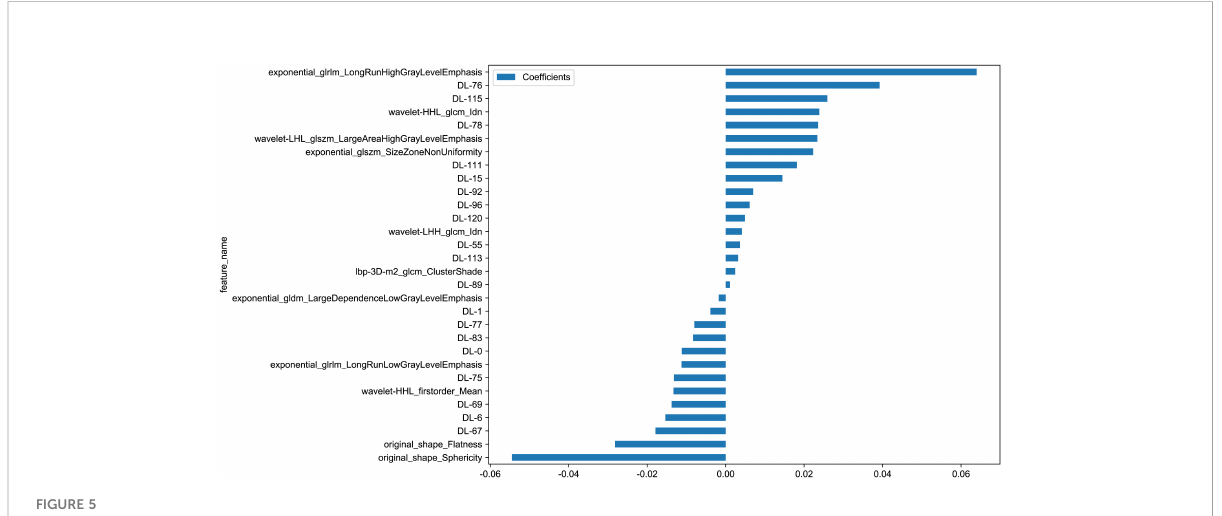
FIGURE 5 Rad-score histogram based on selected